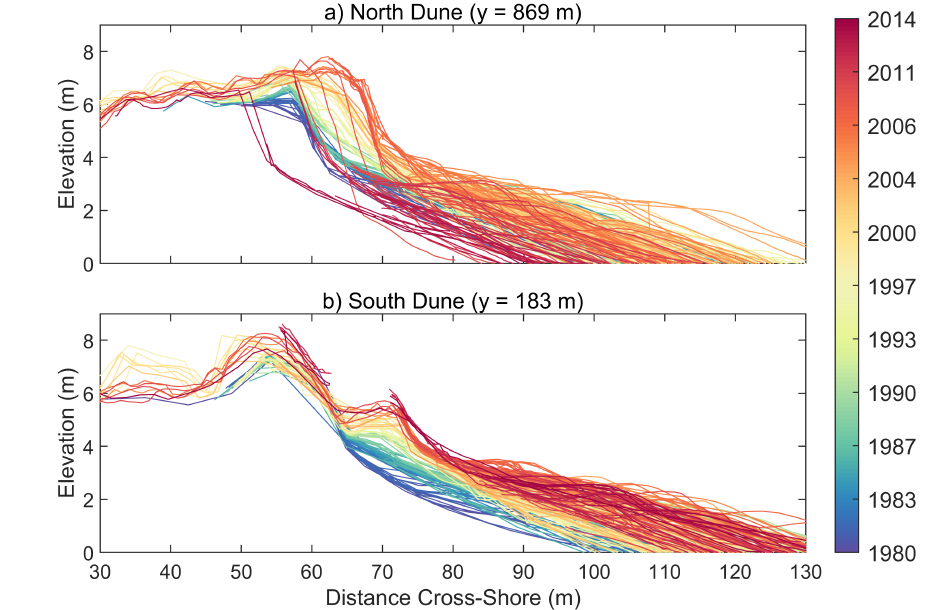
Figure 2. Field Research Facility (FRF) long-term dune evolution. Elevation (m, NAVD88) versus cross-shore position through time (colors increase in time from 1980 (blue) to 2014 (red)) for a cross-shore transect through: ( a ) the northern study site at y = 869 m, and ( b ) the southern study site at y = 183 m. Profile locations are dictated by standard FRF Profile sample